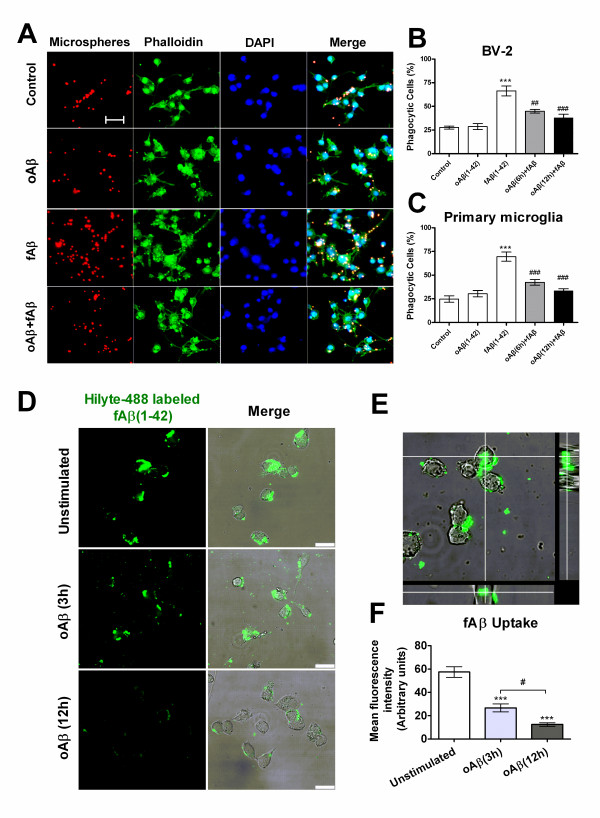
oAβ(1-42) inhibits fAβ(1-42)-stimulated microglial phagocytosis. BV-2 cells or primary microglia induced by oAβ(1-42) (1.0 μM), fAβ(1-42) (5.0 μM) alone or pretreatment of oAβ(1-42) for 6 h or 12 h followed by fAβ(1-42) treatment for 30 min. Fluorescent microspheres (red) were then added for 30 min. Cells were fixed with 4% PFA and stained with alexa488-conjugated phalloidin to visualize F-actin (green). The nucleus was visualized with DAPI (blue). (A) Fluorescent images of the distinct microglial phagocytosis. Scale bar = 40 μm. (B, C) Quantification of Aβ-mediated microglial phagocytosis. Data are presented as mean ± S.E. ***P < 0.001, compared with the control. ##P < 0.01, ###P < 0.001, compared with fAβ(1-42) alone. (D-F) Fluorescent labeled fAβ(1-42) internalization in microglia. Cells were pre-stimulated without or with oAβ(1-42) (1.0 μM) for 3 h or for 12 h, then incubated with Hilyte-488 labeled fAβ(1-42) (5.0 μM) for 30 min, and treated cells were fixed with 4% PFA and scanned under confocal microscope. Confocal images of microglial cells ingesting green Hilyte-488 labeled fAβ were shown in the x-y plane (D left). Overlays of phase-contrast and confocal images were shown in D right. Scale bars = 25 μm. (E) z-axis scans of cuts through the cells. (F) Quantification of internalized fluorescent fAβ in microglial cells. Values were expressed as mean fluorescence intensity (arbitrary units) of internalized fAβ per cell. Data are presented as mean ± S.E. ***P < 0.001, compared with the unstimulated control group. #P < 0.05, between 3 h and 12 h of oAβ stimulation.